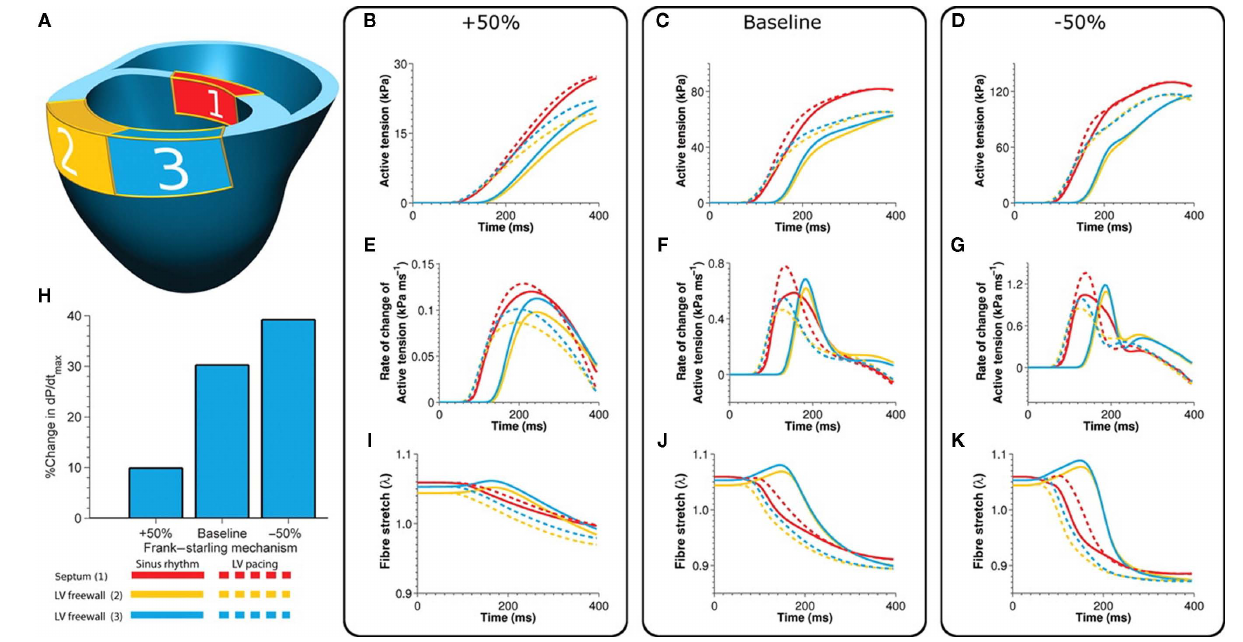
FIGURE 6 |Active tension, rate of tension development, and regional stretch in the presence of baseline, amplified, and attenuated length-dependent tension regulation for the three regions shown in (A), (1) septum (red), (2) posterior lateral wall (yellow), and (3) anterior lateral wall (blue). Line colors correspond to these regions. Dashed and solid lines